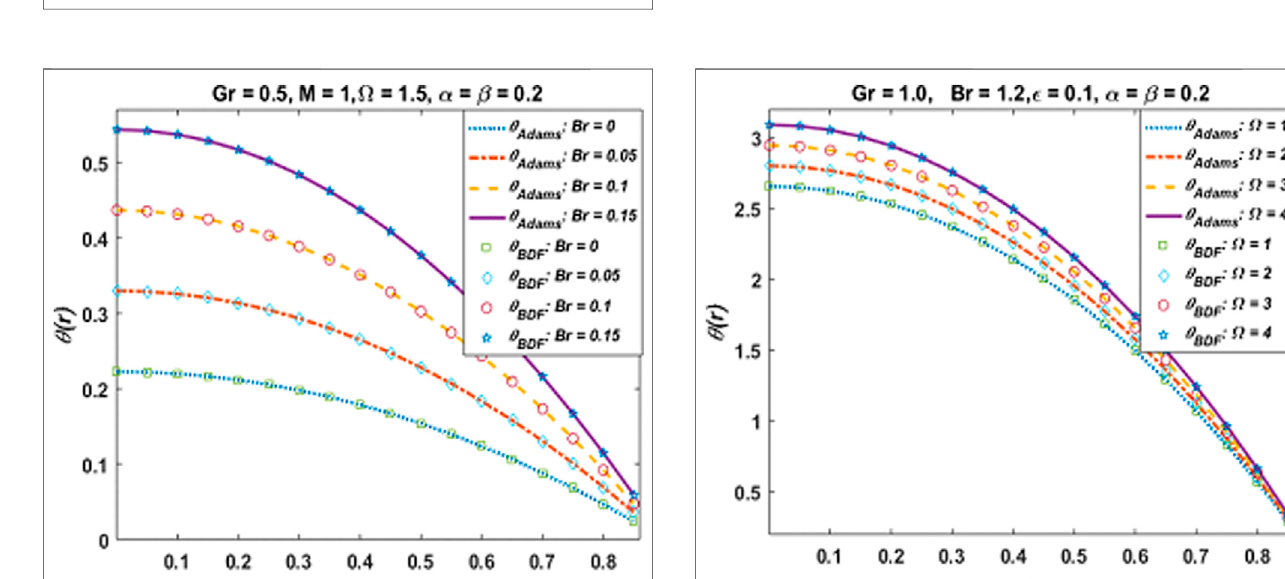
FIGURE 11 | Behavior of temperature pro fi le against magnetic parameter.